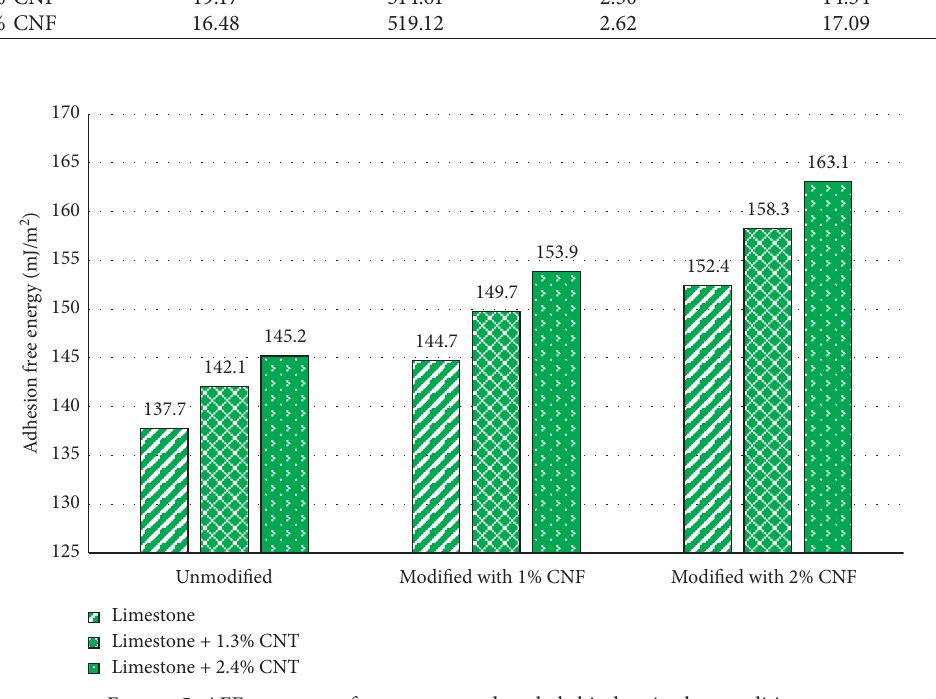
Figure 5: AFE amounts of aggregates and asphalt binders in dry condition.